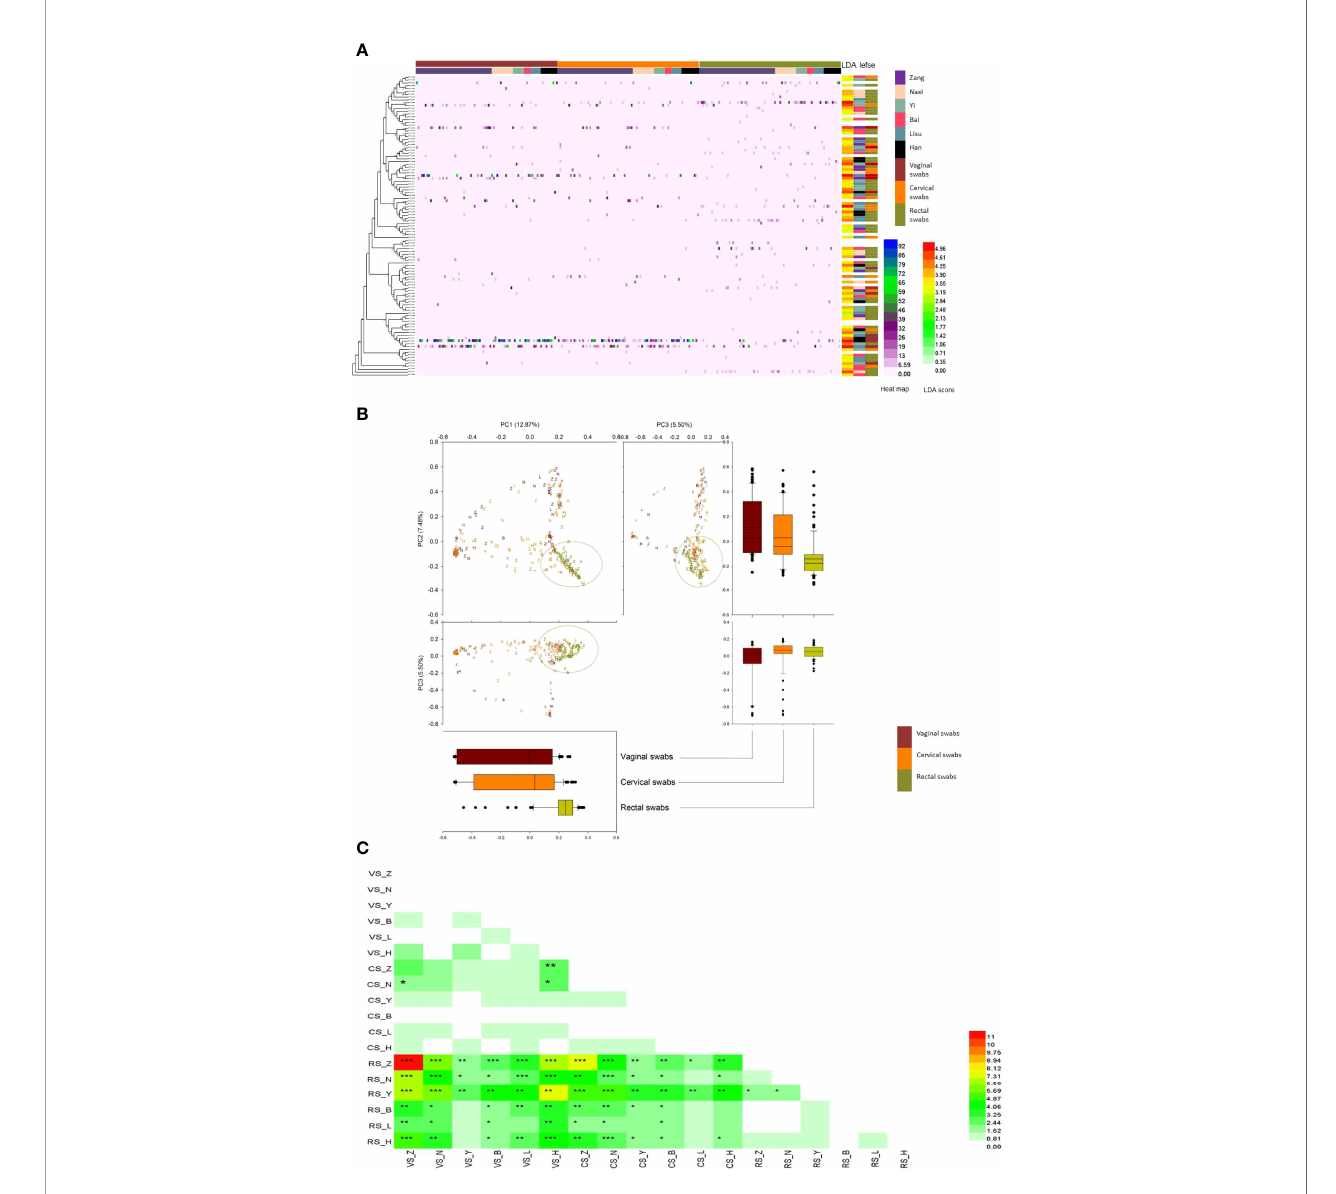
FIGURE 3 | Comparison of the microbiomes of vaginal, cervical, and rectal swab samples among six ethnic groups. (A) Heatmap and phylogenetic analysis of the 107 most abundant OTUs (sequence percentages > 0.5%) at a 0.03 cutoff in all samples. OTUs that were signi fi cantly elevated are shown in different colors in the right column of the heatmap calculated using LDA scores. OTUs that were signi fi cantly elevated as calculated by LEfSe analysis are shown in different colors according to the six ethnic groups (the right column next to the LDA scores) and vaginal, cervical, and rectal swabs (the column on the far right). Color legend: vaginal swabs, dark brown; cervical swabs, orange; rectal swabs, mustard green; Zang, purple; Naxi, skin; Yi, mint green; Bai, rose red; Lisu, dark gray; Han, black. (B) PCA plot based on relative taxon abundance. Samples are marked by the group type. The boxplots represented the distribution of PC values corresponding to the coordinate axis. Each ethnic group is represented by its initials. Color legend: vaginal swabs, dark brown; cervical swabs, orange; rectal swabs. (C) AMOVA distance matrix between each pair of samples. *p < 0.05, **p < 0.01, ***p < 0.001. VS, vaginal swabs; CS, cervical swabs; RS, rectal swabs. Each ethnic group is represented by its